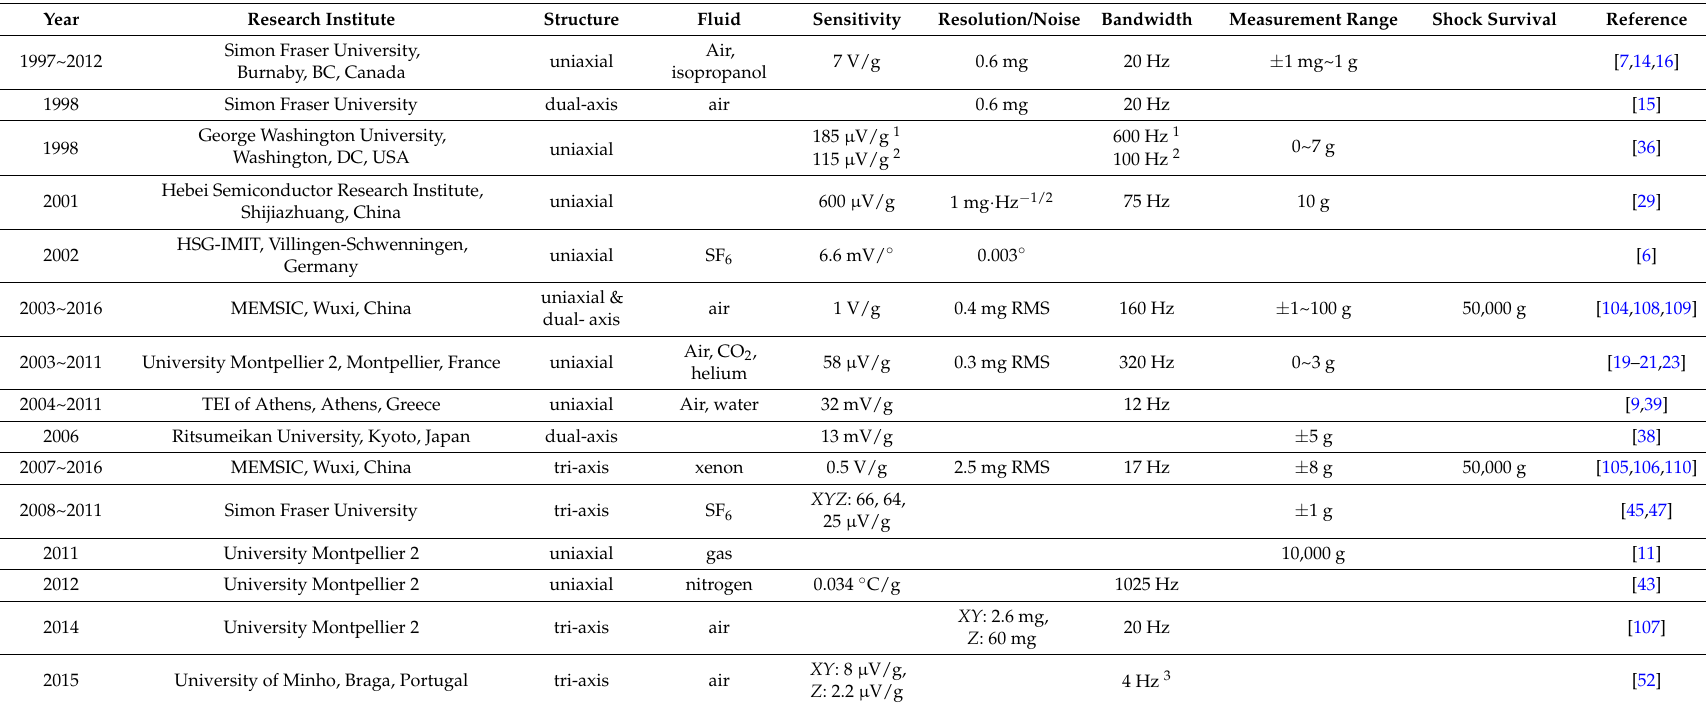
Table 1. Typical research results of thermal fluid